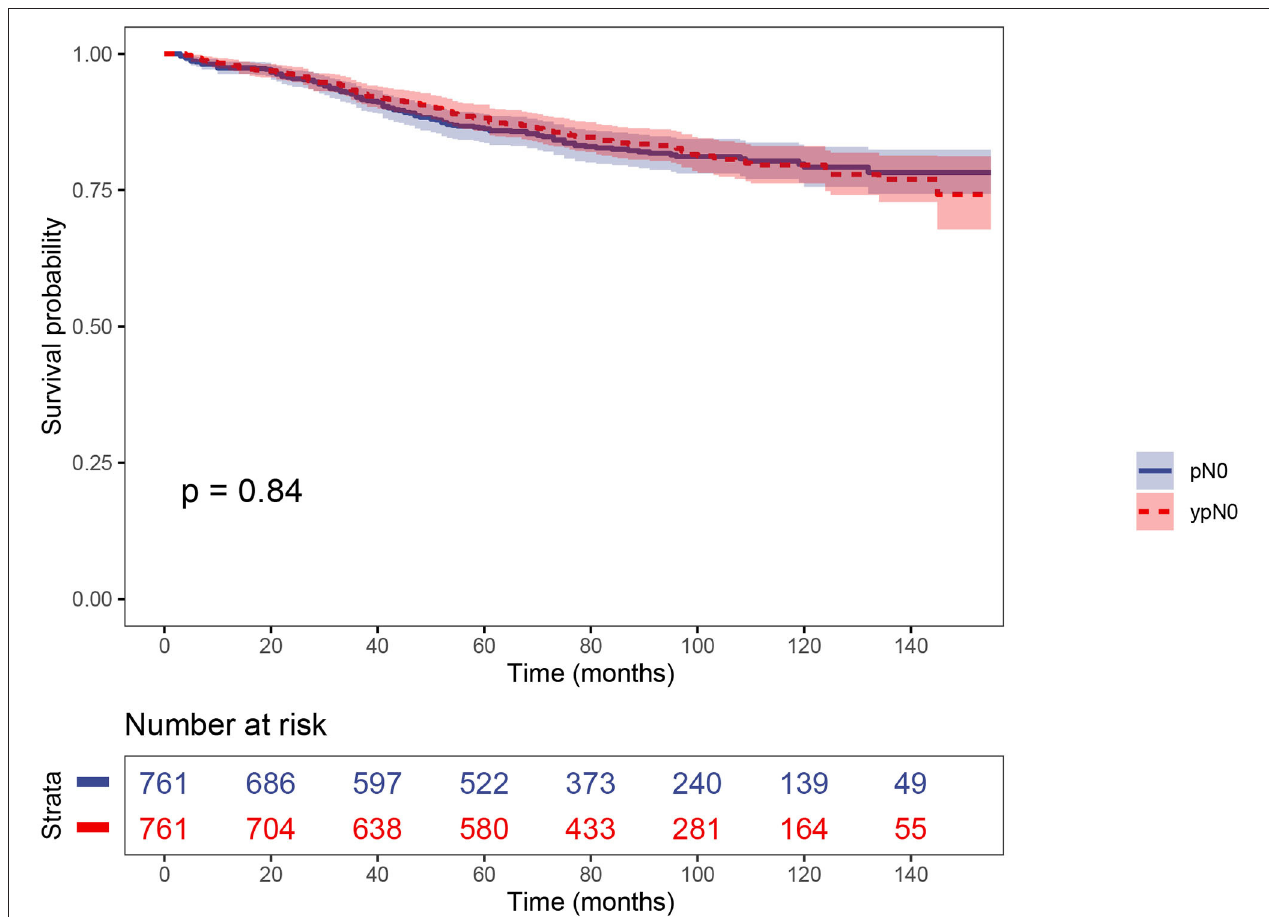
FIGURE 4 | The CSS curves of ypN0 and pN0 groups using Kaplan-meier estimates after